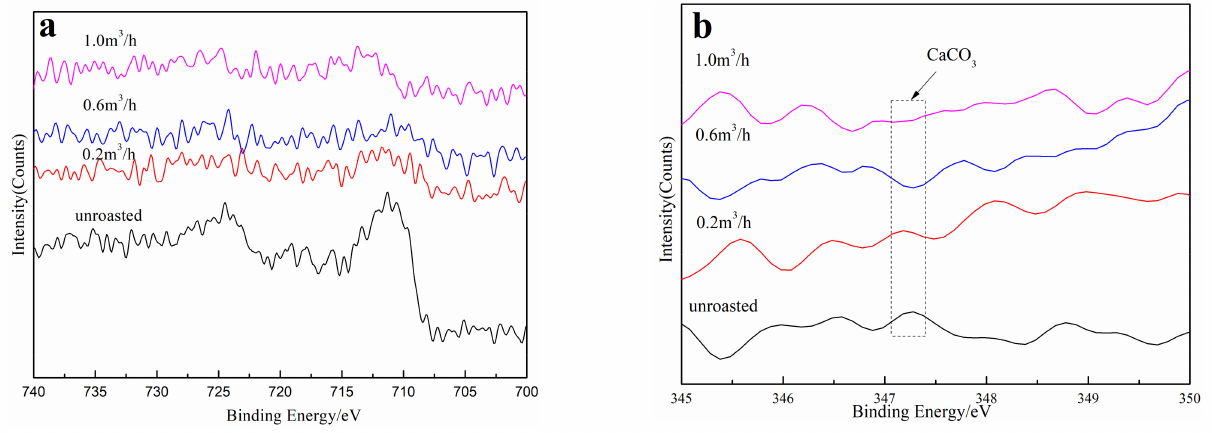
Figure 6. Ca2p ( a ) and Fe2p ( b ) narrow peak scanning of XPS on calcine surface at different ventilatory